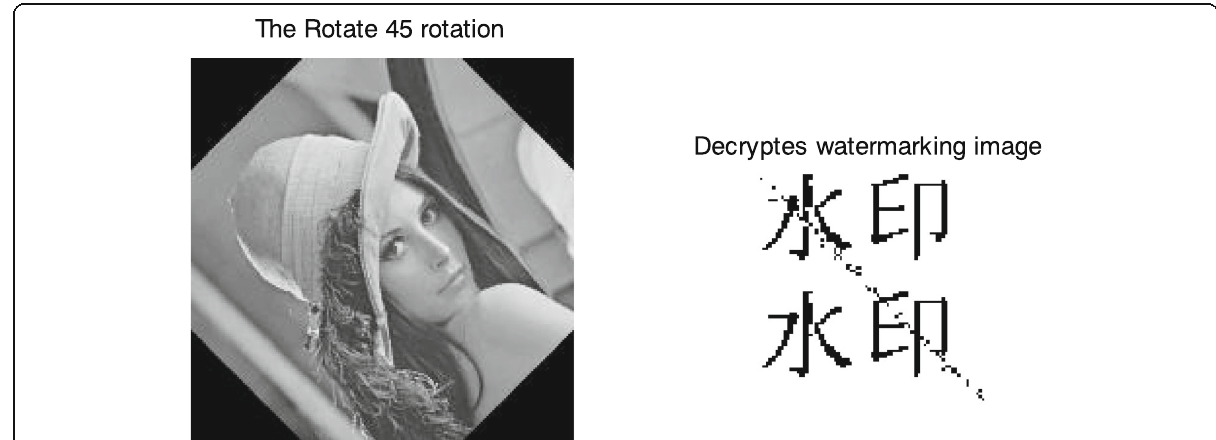
Fig. 15 Rotate 45 rotation and decryption watermark